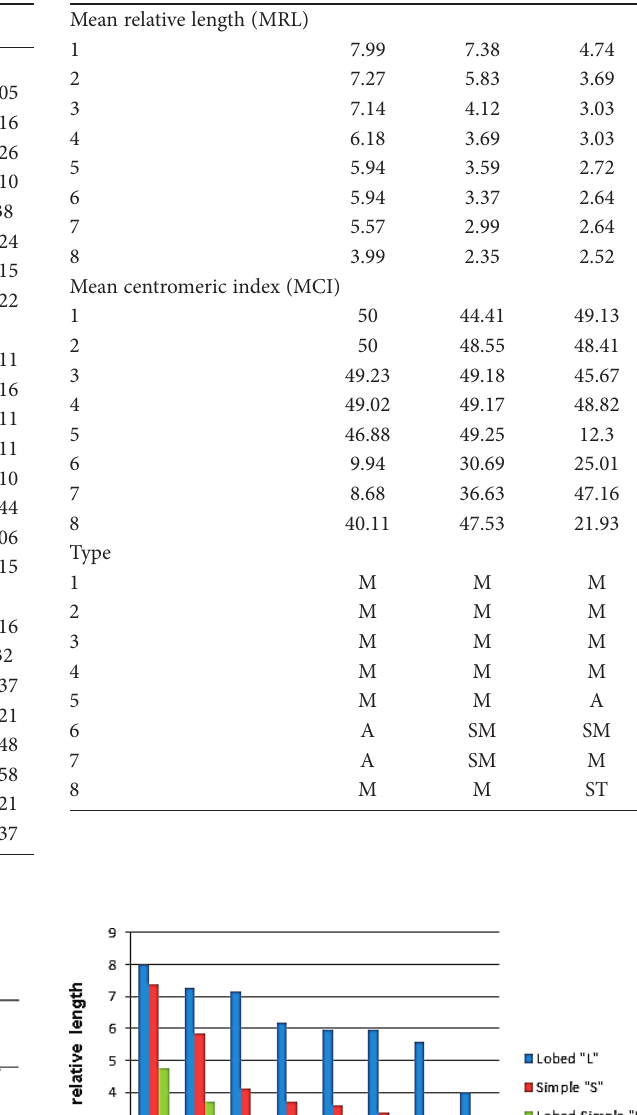
Table 2. Karyotyping data for the studied C. bursa pastoris genotytpes, L: lobed, S: simple, LS: lobed-simple, A: Acrocentric, M: Metacentric, SM: Submetacentric, ST: Subtelocentric.